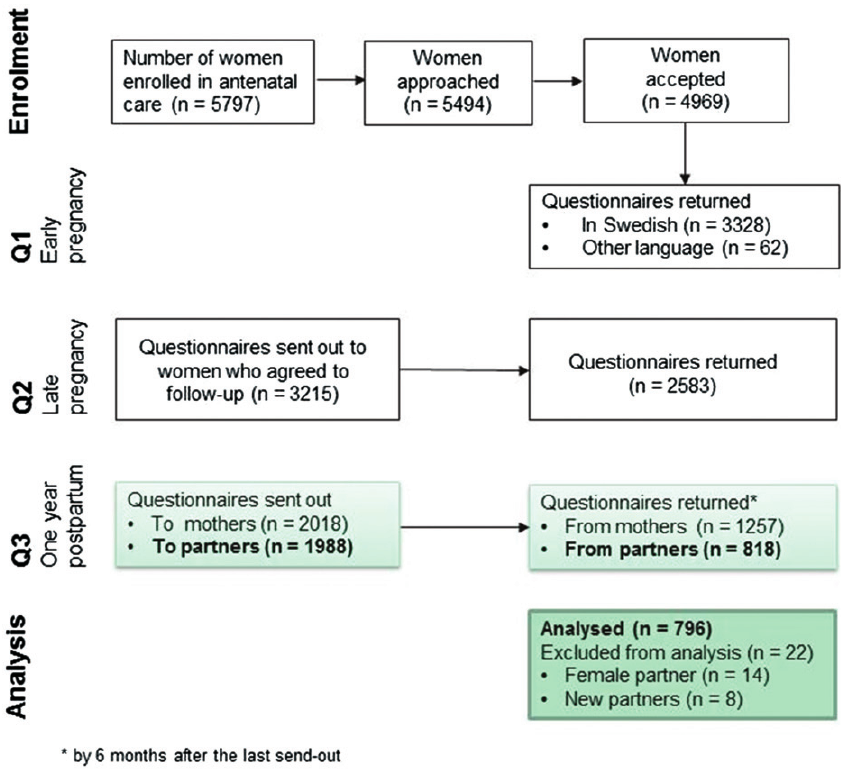
Figure 1. Flow chart of the study Table 1. Assessment template to evaluate fertility knowledge. Question